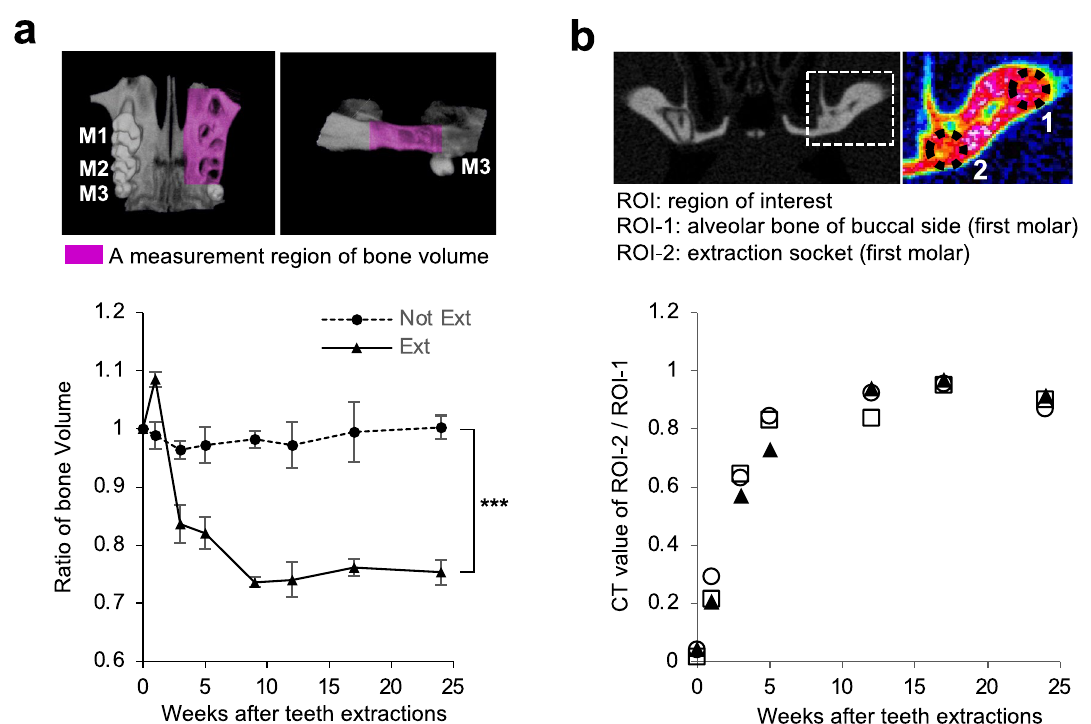
Figure 1. Resorption of the maxillary alveolar bone after teeth extractions in mice. ( a ) Bone volumes of both the extracted and non-extracted sides were determined with μCT analysis. The measurement range of bone volume is indicated in purple in the µCT-3D image of the upper images, which is between the M1 mesial buccal root and M2 distal buccal root. M1, M2, and M3 denote the first molar, second molar, and third molar, respectively. The graph in the lower panel shows the time-dependent changes in bone volume of the teeth- extracted and the non-extracted sides and are expressed as a ratio of the bone volume on day 0 after tooth extraction in the same individual. The data are expressed as mean ± S.D. (n = 3) and are representative of three independent experiments. ( b ) The selected regions of interest (ROIs) in or areas near the extraction socket of the first molar are displayed in the circled areas of the µCT image in the upper panel. The graph in the lower panel shows the time-dependent changes in the ratio of the CT values of the maxilla alveolar bone of the extracted region (ROI-2) to the non-extracted buccal side (ROI-1). Each symbol represents an individual mouse. The data shown in the graphs are representative of three independent experiments. *** P < 0.005; calculated using two-way